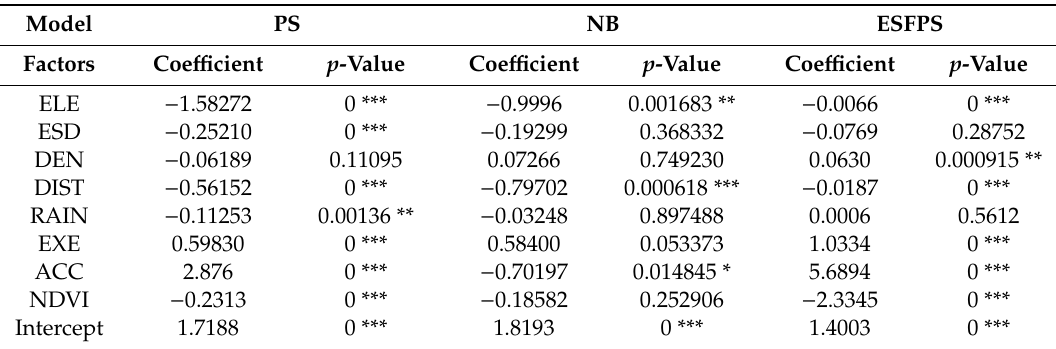
Table 5. Results of the three regressions.